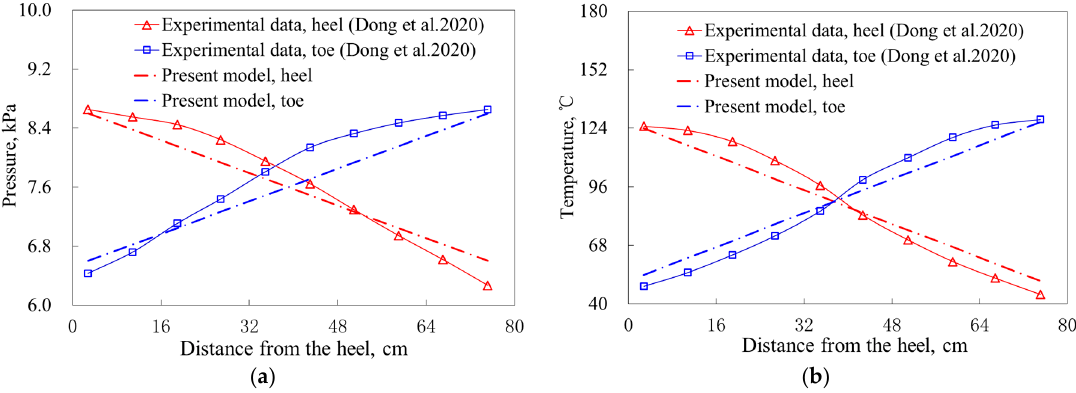
Figure 5. Comparison of the simulated results and experimental data: ( a ) pressure; ( b ) temperature. Table 1. Basic data used in the calculations.